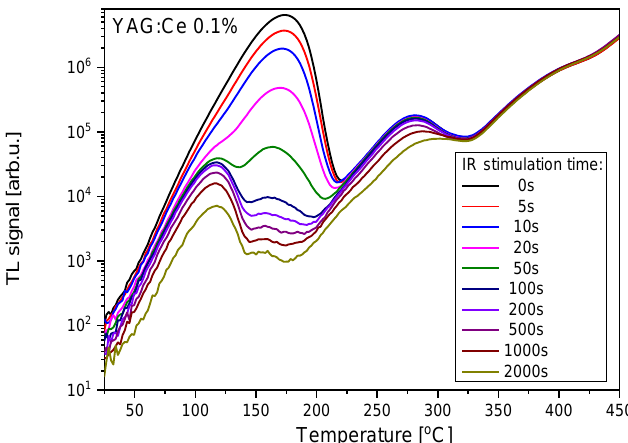
Figure 6. Influence of the variable time of IR illumination on TL glow-curves of YAG:Ce 0.1% crystal. Dose 2 Gy.